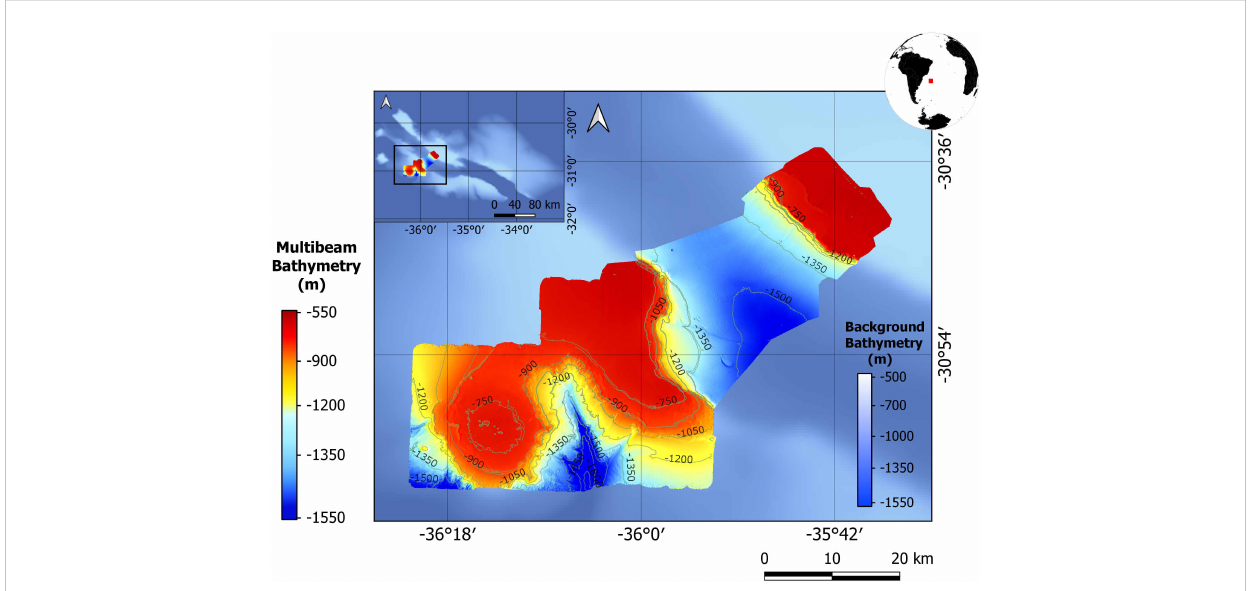
FIGURE 5 Bathymetric map of the study area with the shaded relief (azimuth = 90°, vertical angle = 40°), located in the north portion of the Cruzeiro do Sul Rift (NCSR) in the west portion of the Rio Grande Rise. The bathymetry data on the NCSR were acquired by the multibeam echo sound from both cruises during MarineE-tech Project, the RGR-1 grid with 25 meters and the DY094 grid with 15 meters (Murton et al., 2018). The isobath spacing is 150 meters. The bathymetry in the background is from GEBCO_2020 with a spatial resolution of 15 arc-second (GEBCO Compilation Group, 2020). This bathymetric base background was maintained for all the other fi